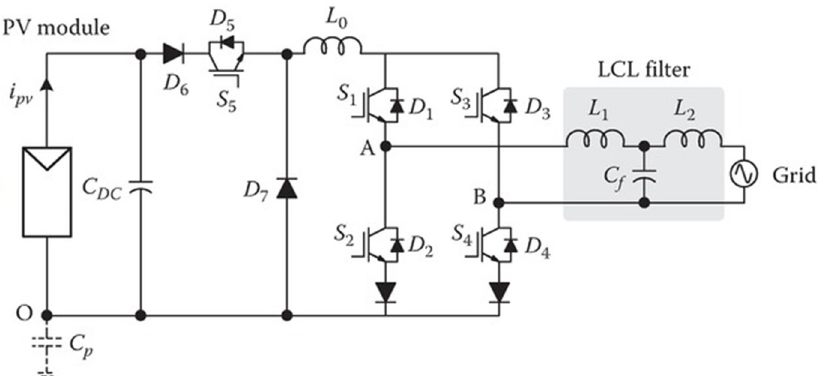
Figure 7. Boost converter full bridge transformerless inverter .